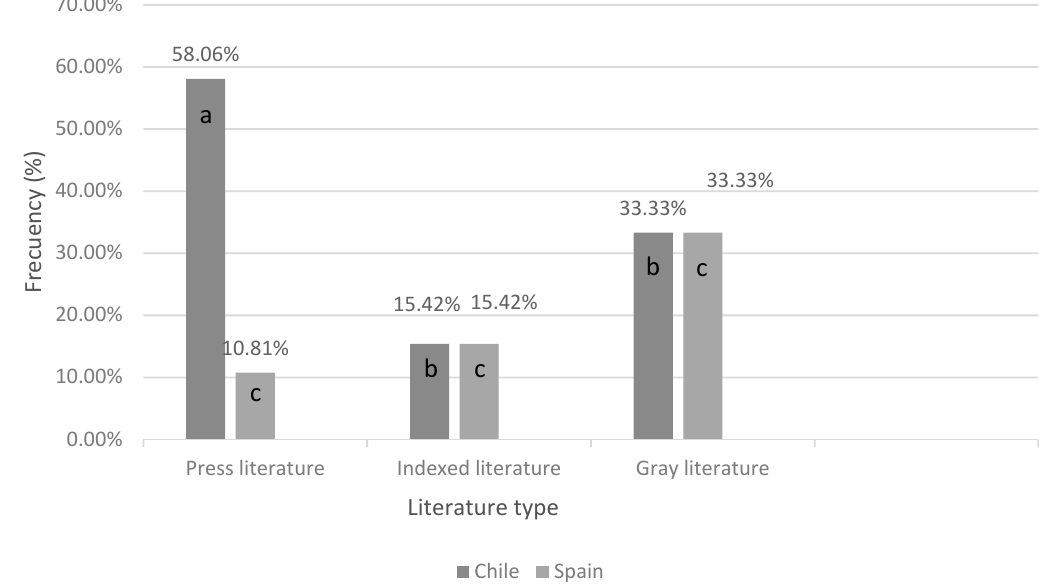
Figure 3. Frequency of records that report bites resulting in death in the different types of literature in Chile and Spain. The letters a and b refer to statistically significant differences in the Chilean literature, and the letter c indicates that there are no statistically significant differences between the Spanish literatures.